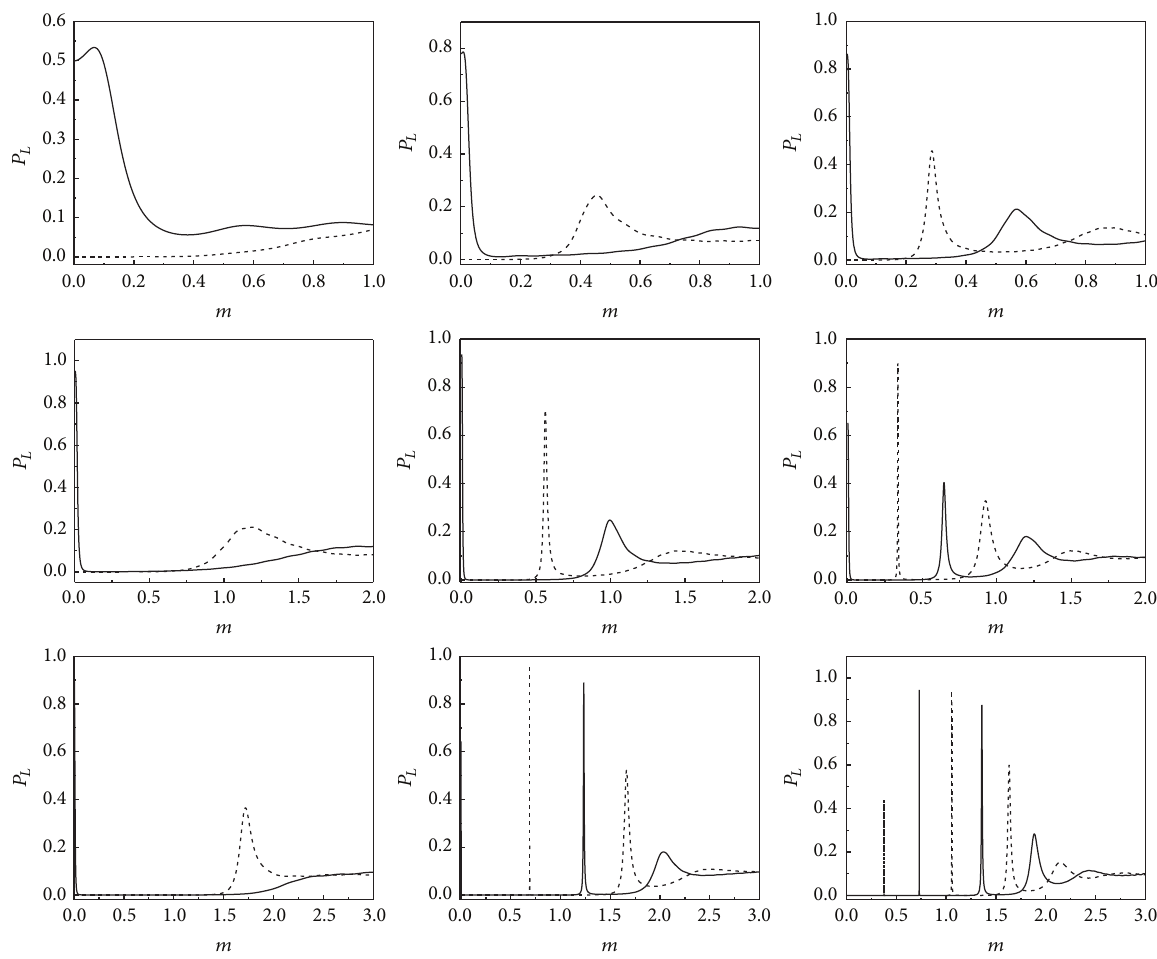
Figure 4: Plots of relative probability for left-handed fermion resonances with 𝑎 = 1.0 (left column), 𝑎 = 3.0 (middle column), and 𝑎 = 5.0 (right column). Coupling constants are 𝜂 = 0.5 (first raw), 𝜂 = 1.0 (second raw), and 𝜂 = 2.0 (third raw). Solid lines and dashed lines correspond to even and odd parity, respectively. In all cases 𝜆 = 1.0